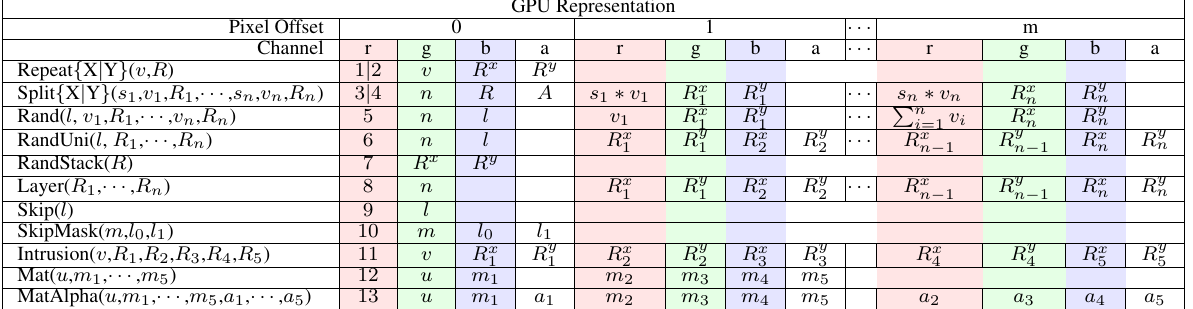
Figure 3: Definition of operators provided by our system (cf. Sec. 3) and their representation in a texture on the GPU (cf. Sec. 4).